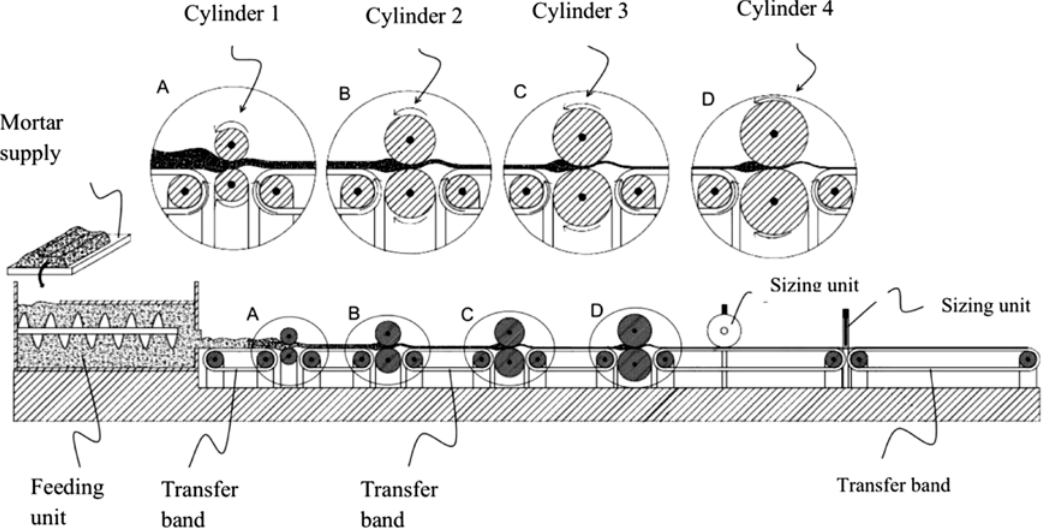
Figure 1 Schematic description of calender